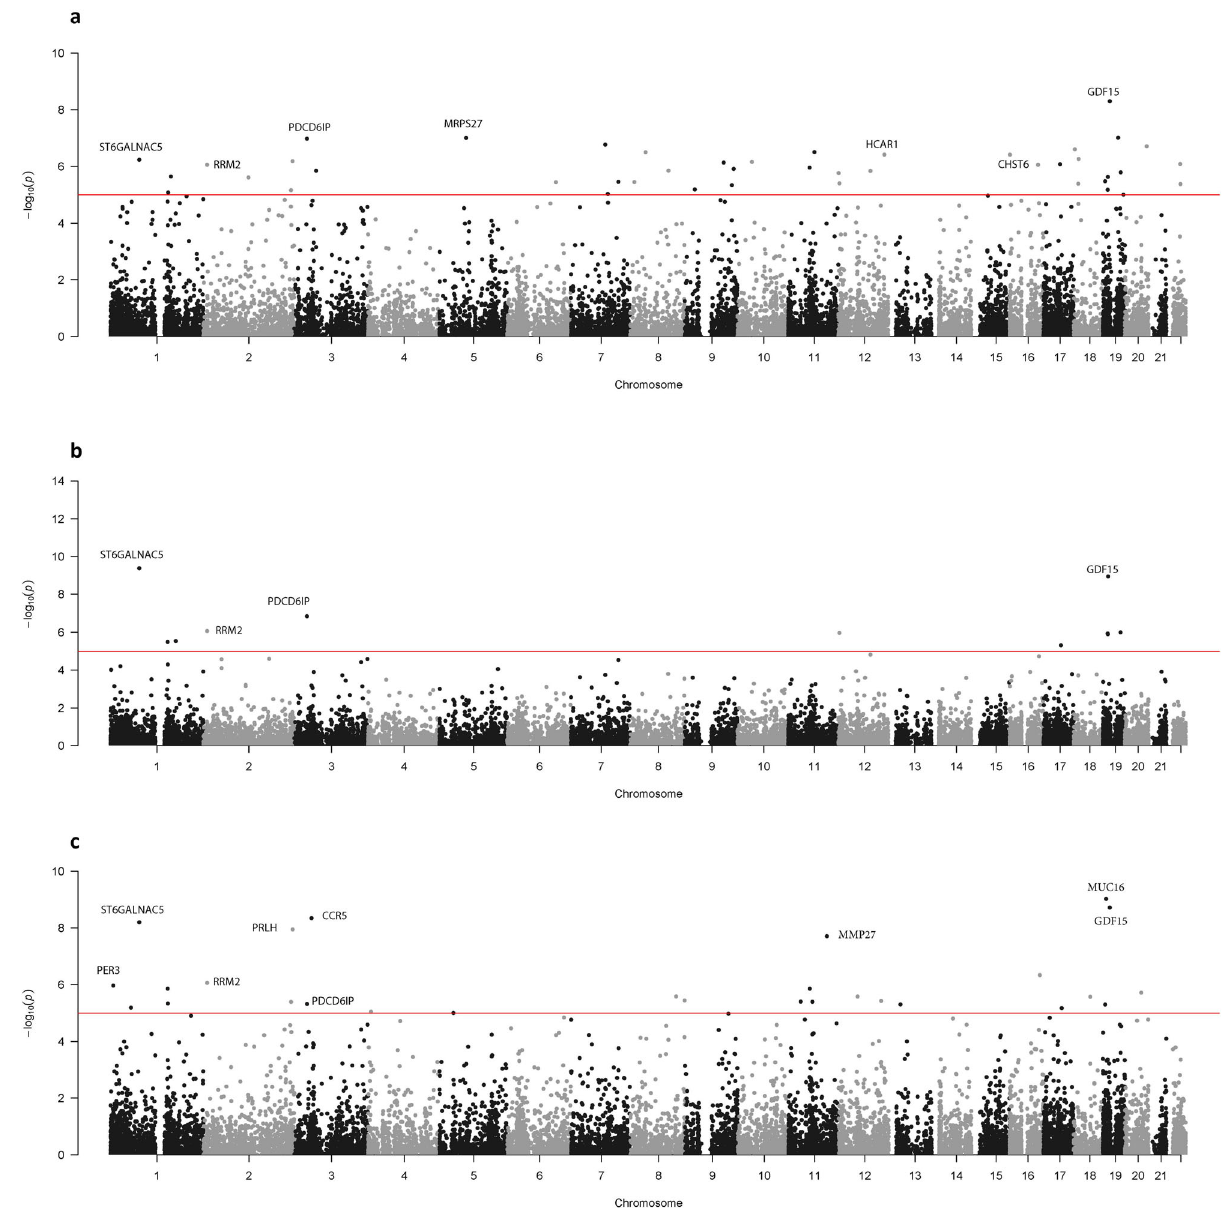
Fig. 1 P -values of the multiethnic meta-analysis. The gene-based p -values of the meta-analysis association study combining all fi ve cohorts ( N = 27,006) using the ( a ) EMMAX-VT test, ( b ) EMMAX-CMC test, and ( c ) ACAT. The line represents the genome-wide signi fi cant threshold of 1 ×10 − 5 . These plots are based on results in Supplementary Data 9 – 11,